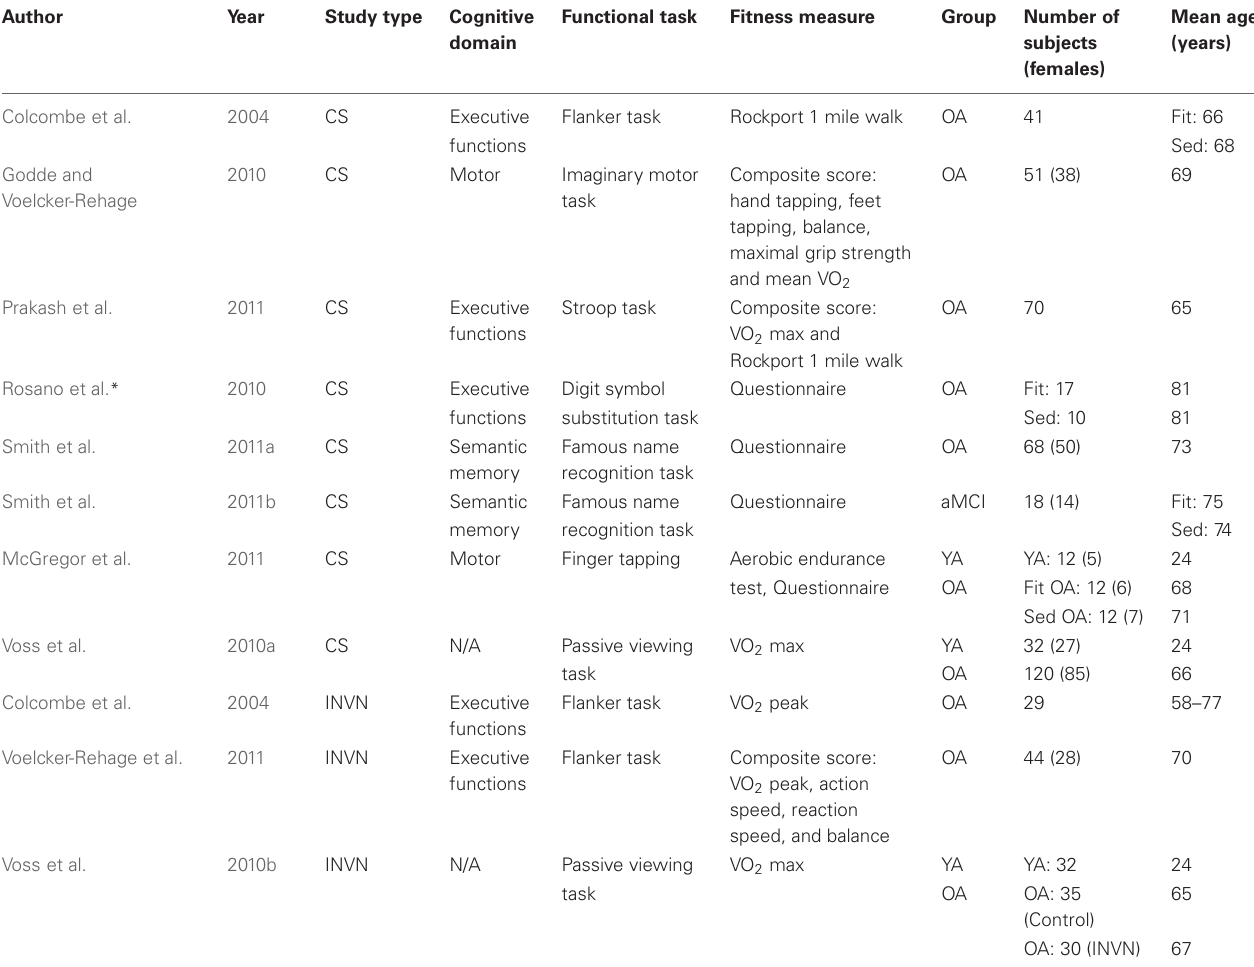
Table 2 | Cross-sectional (CS) and exercise intervention (INVN) studies examining the relationship between cardiorespiratory fitness and brain function (all studies used